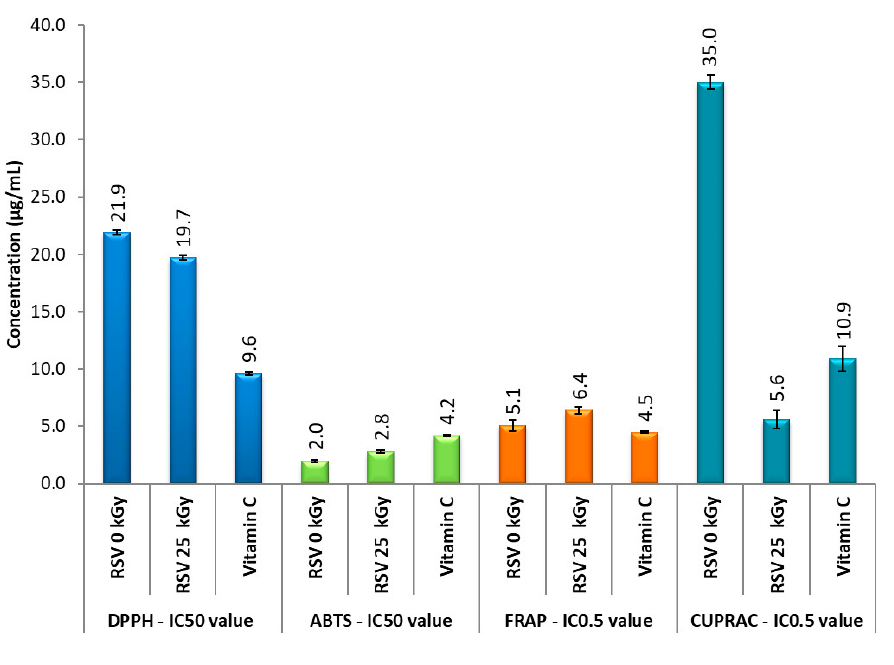
Figure 3. Summary of the results of antioxidant tests. Legend: X-axis—IC 50 (DPPH and ABTS assay) or IC 0.5 value (CUPRAC and FRAP assay), Y-axis—concentration of the sample, RSV 0 kGy—non- irradiated resveratrol, RSV 25 kGy—irradiated resveratrol.